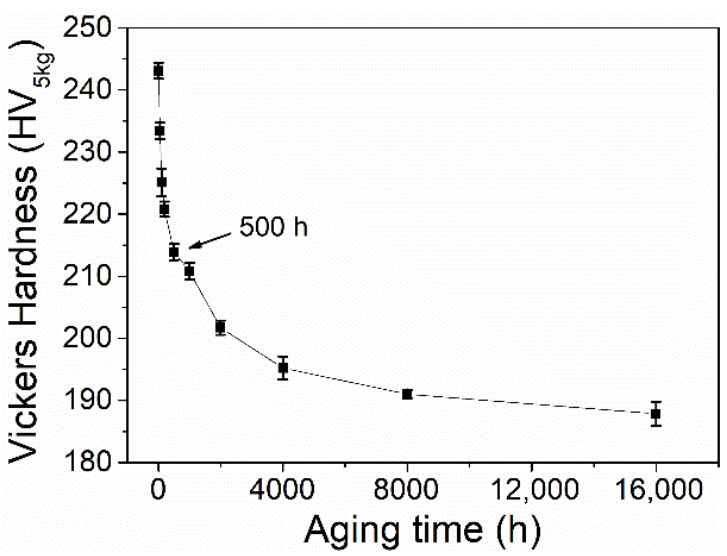
up to 100,000 h [9].